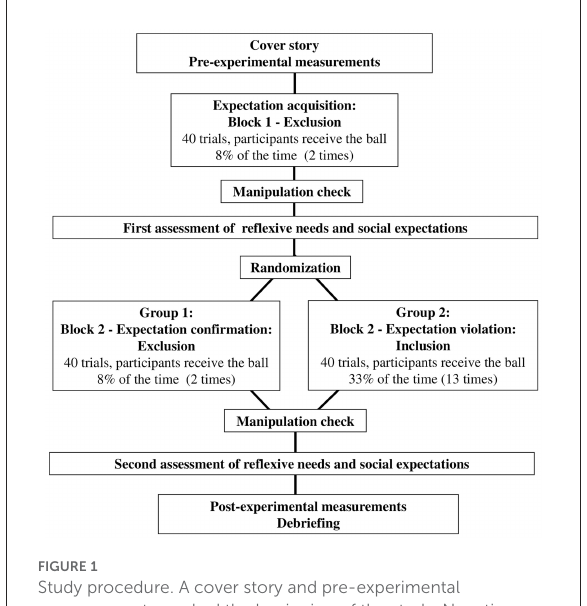
FIGURE1 Study procedure. A cover story and pre-experimental measurements marked the beginning of the study. Negative social expectations were built up in the first round of the online ballgame Cyberball (40 trials, participants received the ball twice). After the first round, we performed a manipulation check. Social expectations and reflexive needs were assessed for the first time. The second round then followed. After randomization, the participants either experienced social exclusion (Group 1—expectation confirmation, 40